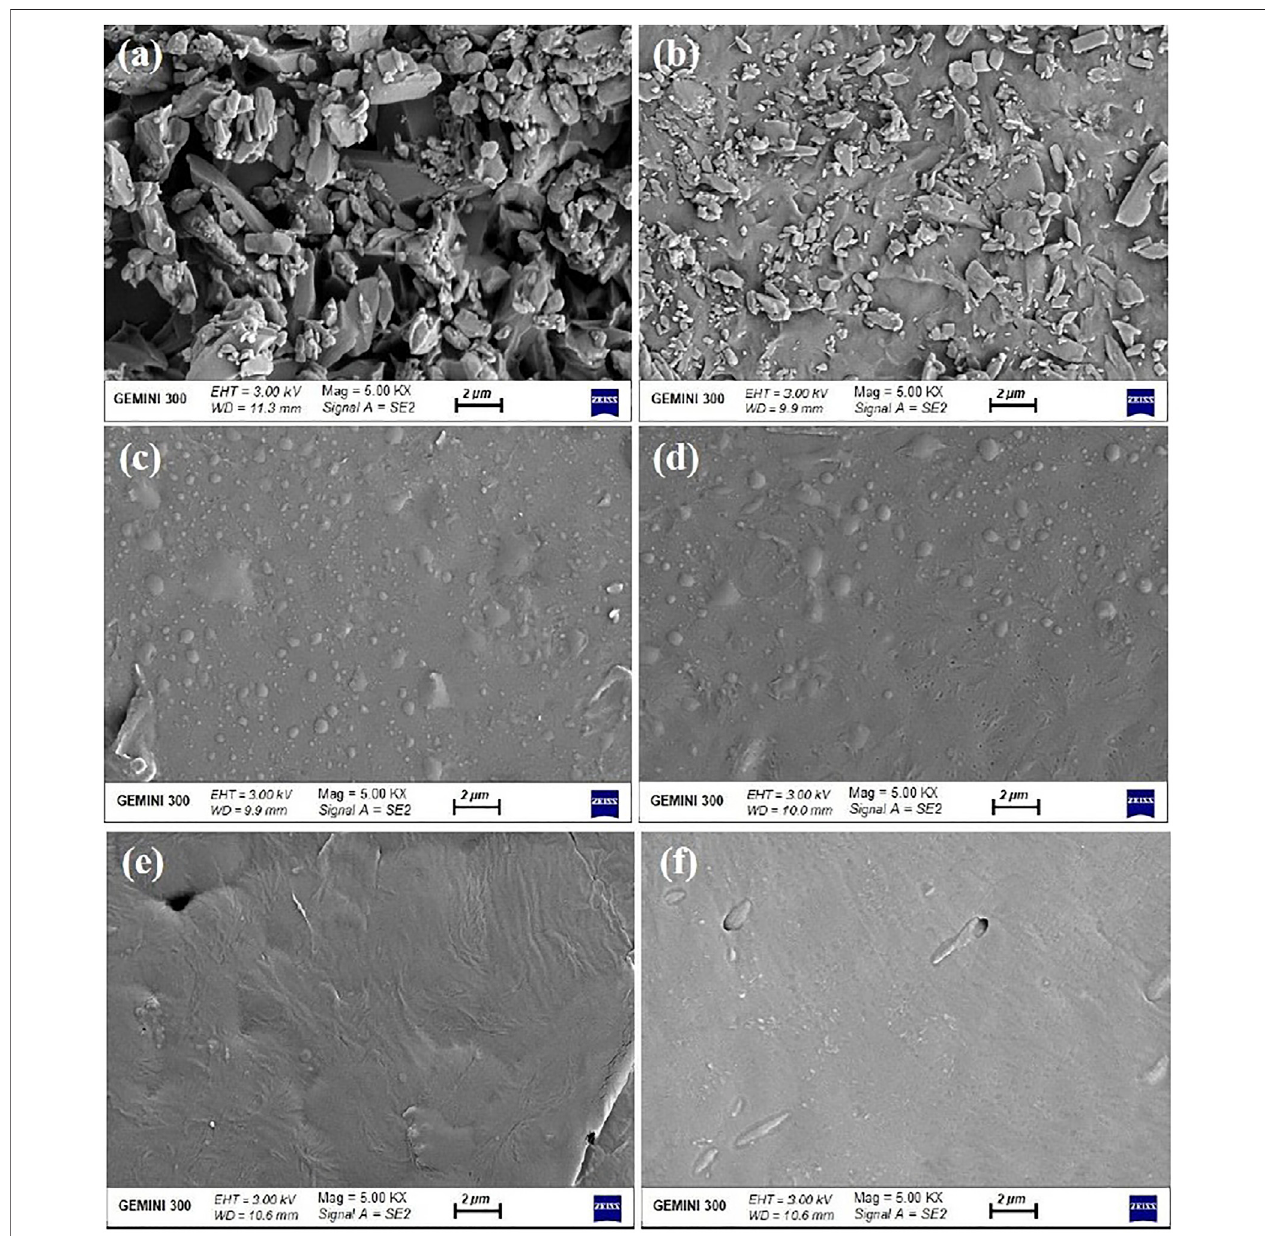
FIGURE 4 | SEM micrographs showing morphology of (A) Pure PBS; and PBS/BP blends at: (B) 90/10; (C) 80/20; (D) 70/30; (E) 60/40; (F) 50/50 wt%.